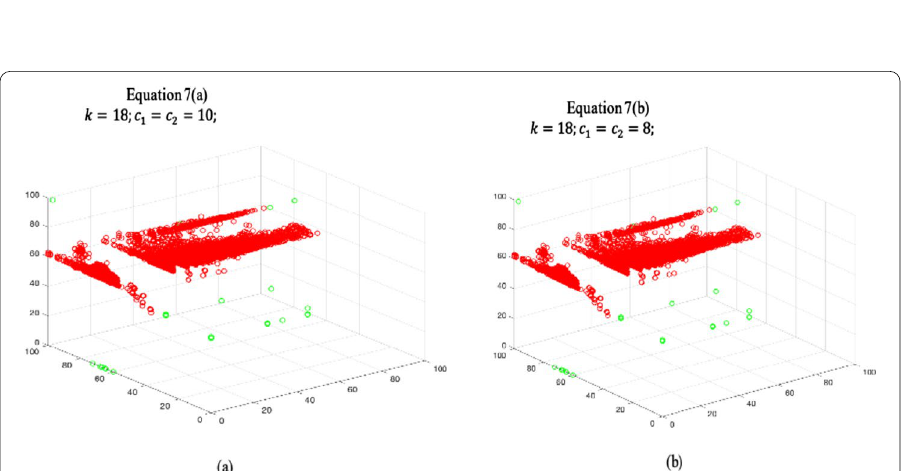
Fig. 13 a Results achieved using the boxplot with extreme values proposed in Eq. 7(a). Red points are inliers and green are outliers. b Ress achieved using the boxplot with extreme values proposed in Eq. 7(b). Red points are inliers and green are